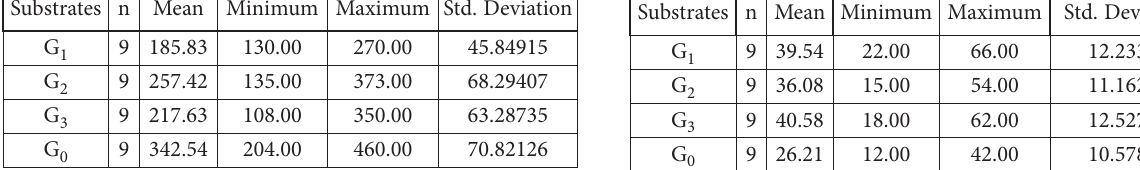
Table 3. Measured drainage amounts according to substrates Table 5. Average moisture content values according to (mL) Substrates n Mean Minimum Maximum Std. Deviation